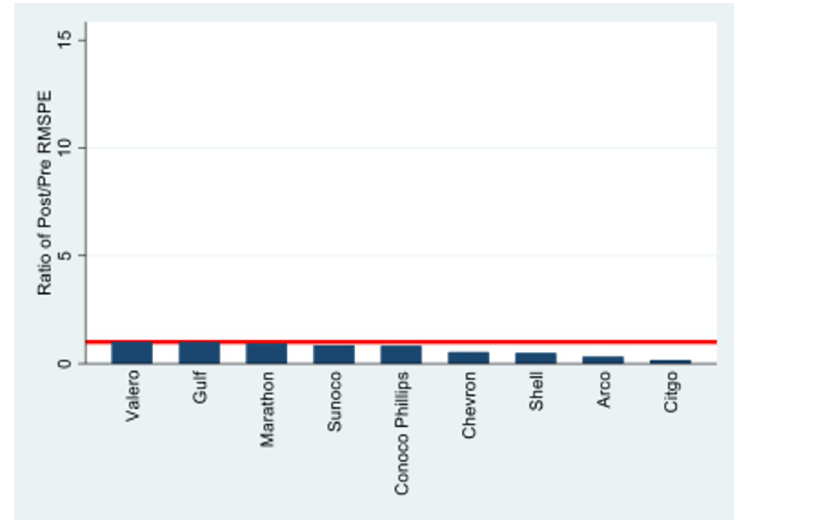
Fig 4. RMSPE ratios for non-BP oil